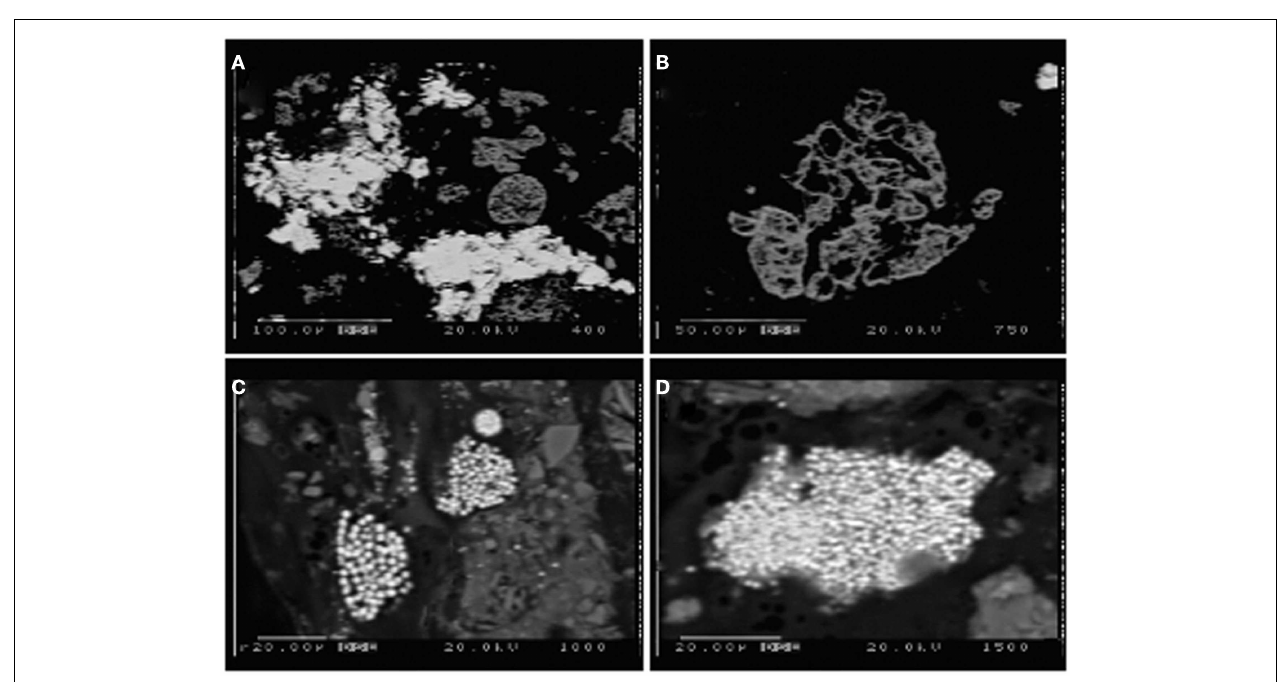
FIGURE 6 | Electron microprobe images of Stege Marsh sediments. (A) weathered hematite with ZnS infill and/or overgrowth from acid pond sediments, (B) weathered hematite in acid pond sediments, (C,D) fine-grained FeS 2 in tidal slough sediments. Scale bars are shown individually in each